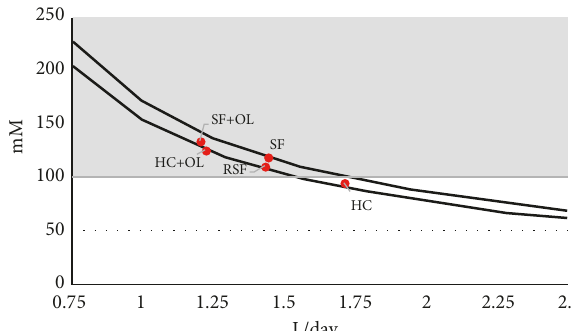
Figure 6: Urinary sodium concentration (Na, mM) in SF and HC, with dietary Ox load (+OL) and in RSF at different states of diuresis (L/day) and critical Na concentration for AGN (100 mM): Na concentration at the average diuresis in the group (o), risk of AGN (shaded